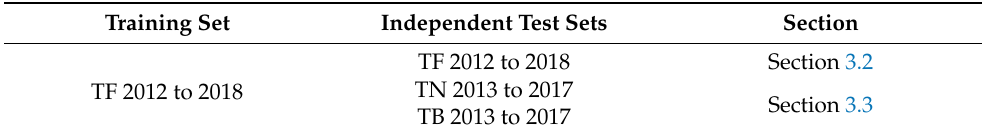
Table 2. Outline of the scenarios performed in the sections below (TF—Touriga Franca; TN—Touriga Nacional; TB—Tinta